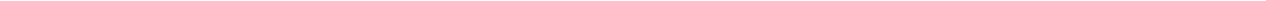
Figure 1 | siRNA screening of histone demethylases required for Wnt/ b -catenin-mediated transcription. ( a ) Analysis of luciferase activity of 293 T/Top cells treated with the indicated siRNA relative to those transfected with scramble siRNA. The relative luciferase activity was normalized against the protein concentration of each cell lysate sample. Values mean ± s.d. from three independent experiments. ( b ) Real-time RT-PCR analysis of the relative expression of histone demethylases in human of 293 T/Top cells transfected with targeted siRNA relative to their expression in cells with scramble siRNA. Values are mean ± s.d. of three independent experiments. ( c ) KDM3A, KDM3B and JMJD1C were knocked down by siRNA in 293T cells. ( d , e ) Knockdown